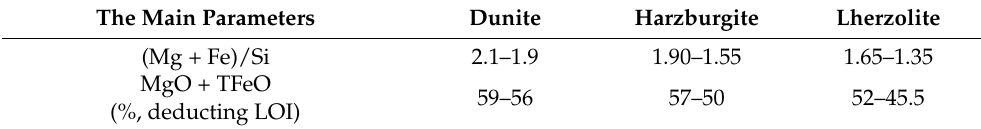
Table 5. The main parameters of discrimination for protolith of metamorphic peridotite [40]. The Main Parameters